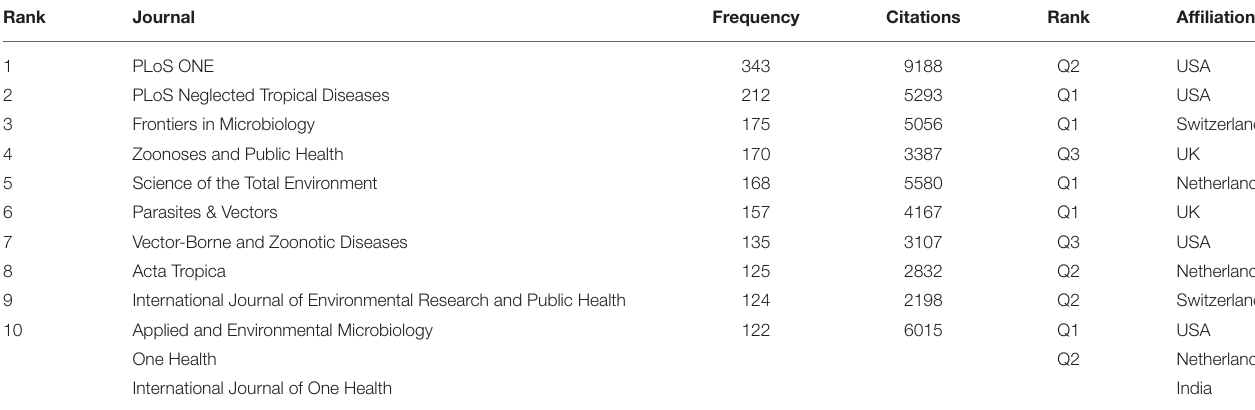
TABLE 1 | Active journals in four priority areas of One Health research, 2003–2021.